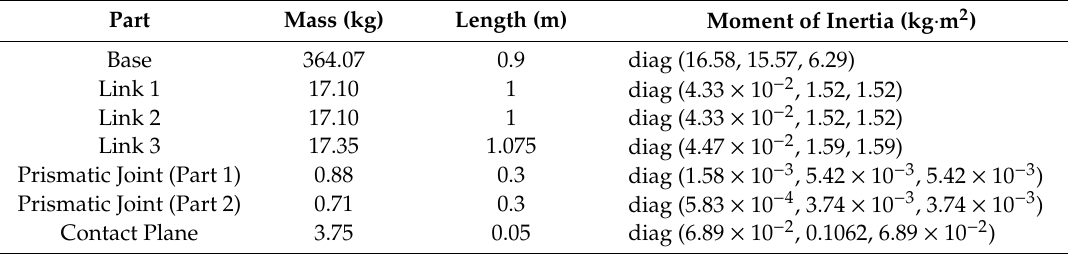
Table 1. Dynamic parameters of space